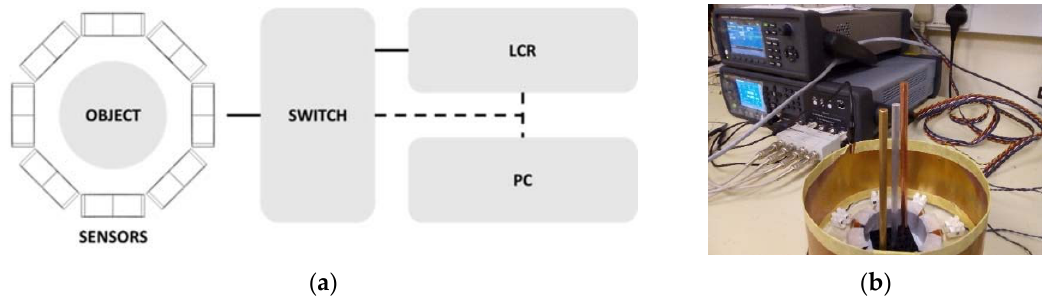
Figure 1. Measurement setup: ( a ) sketch of the sensor array and object in the sensing region, switch, LCR meter and PC connection (signal, solid-line; control, dashed-line); ( b ) photograph of the system. Background measurement is taken for free space (air) condition in the sensing region as a reference.